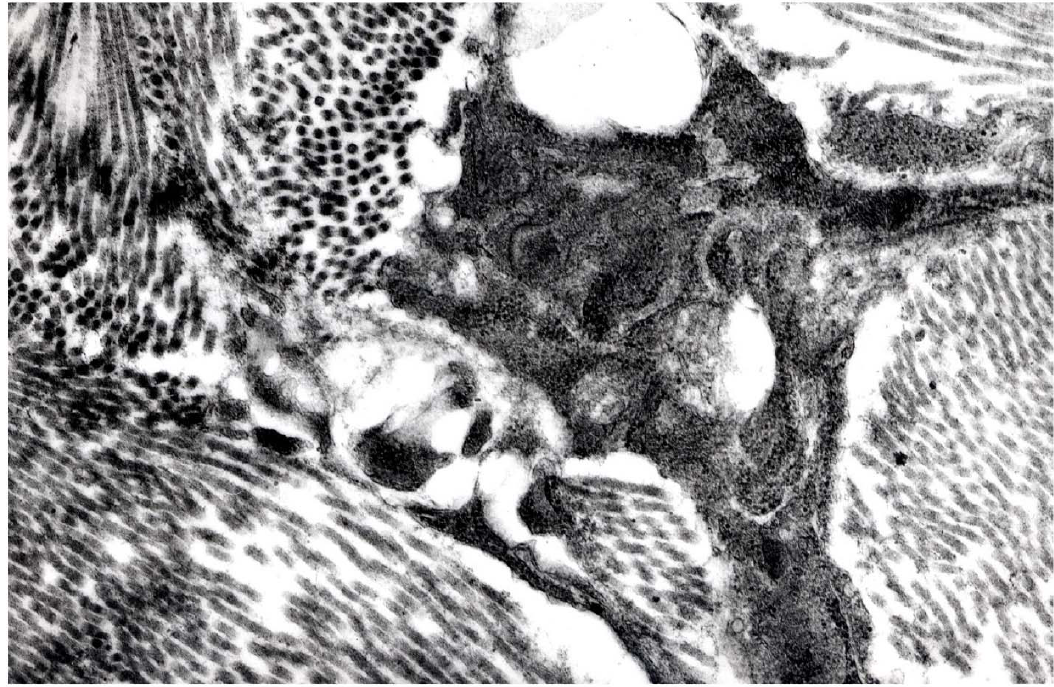
Figure 7. Tumor n. 12 (ATYPICAL SPINDLE CELL-LIKE LIPOMA). Pleomorphic cells with irregular borders within abundant collagen matrix (14,000×).